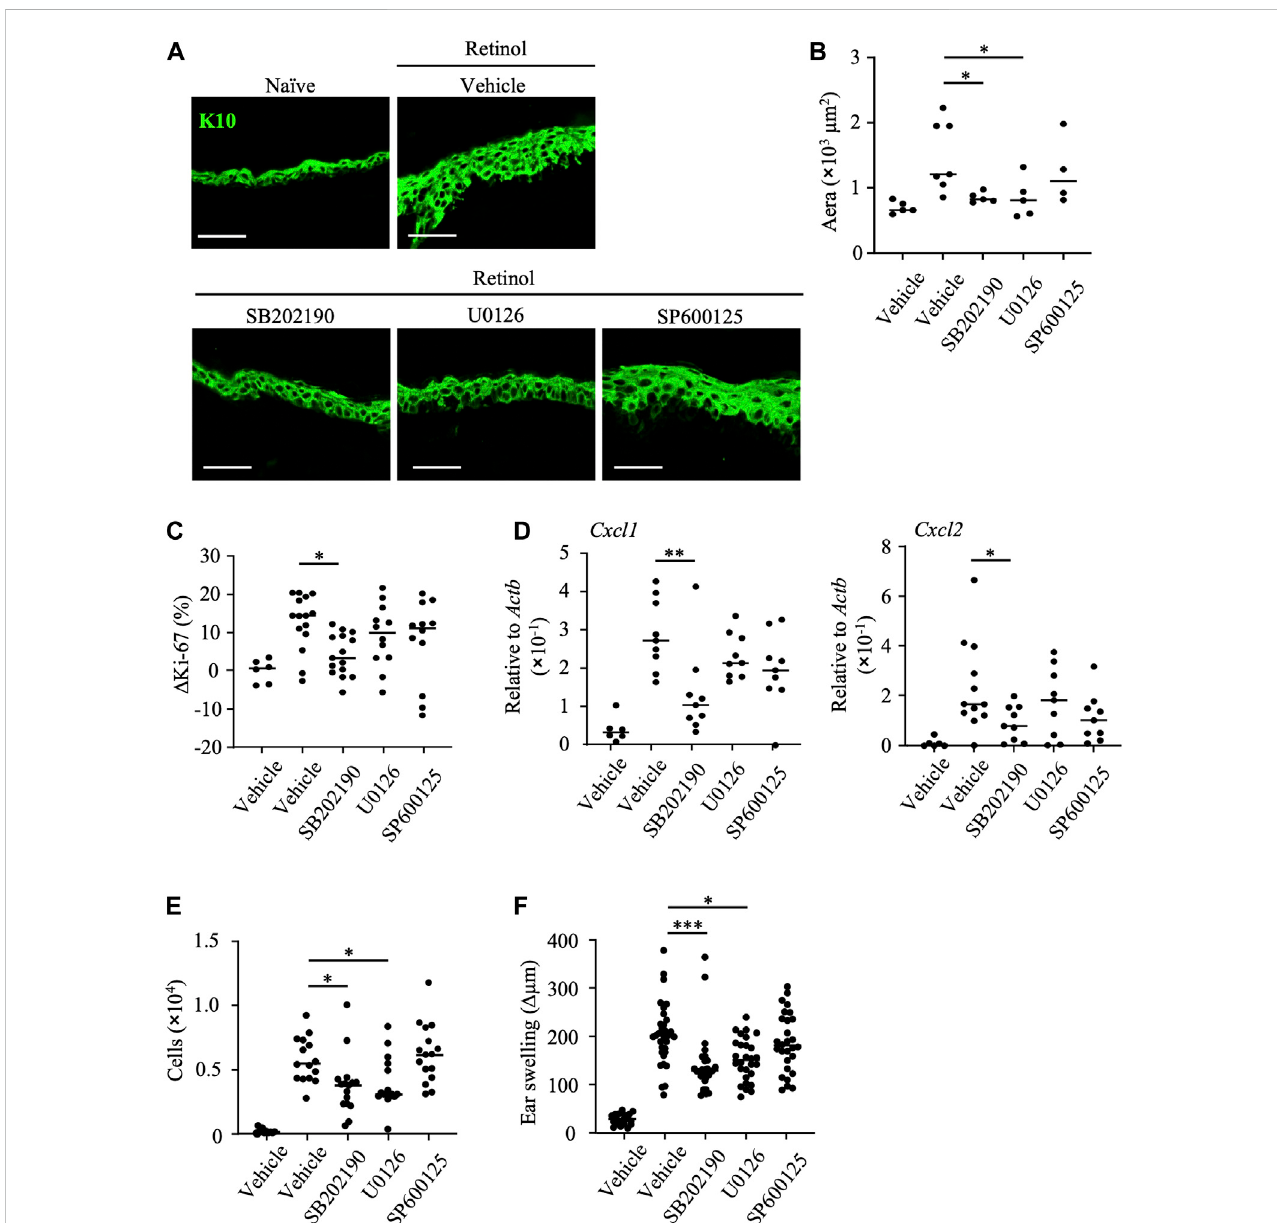
FIGURE 5 Inhibitionofp38MAPKdecreaseskeratinocyteabnormalitiesinducedbyretinol.Aftertopicalapplicationofretinol,thep38MAPKinhibitorSB202190,the MAPK/ERK inhibitor U1026, the JNK inhibitor SP600125, or vehicle was applied topically to both sides of mouse ears. (A) Frozen ear sections obtained on day 4 were stained with anti-K10 antibody. Representative images from three independent experiments are shown. Scale bars, 20 μ m. (B) The area stained for K10 was calculated by using BZ-X700 Analyzer software. (C) The percentage of Ki-67-expressing keratinocytes gated as CD45 − CD31 − CD34 − CD49f + was measured by fl ow cytometry. The rate of increase of Ki-67-positive cells [ Δ Ki-67 (%)] was calculated as (Ki-67 [%] on day 4) — (Ki-67 [%] average in retinol- untreated mice on day 4). Data are combined from four independent experiments. (D) Ear tissues were homogenized to isolate mRNA, and Cxcl1 and Cxcl2 expression was measured by quantitative RT-PCR analysis and normalized to that of Actb . Data are combined from four independent experiments. (E) The number of Ly6G + CD11b + neutrophils was determined on the basis of total cell numbers and fl ow cytometric data. (F) Ear thickness was measured on day 4. Ear swelling ( Δ µm) was calculated as (Ear thickness [µm] on day 4) — (Ear thickness [µm] before the fi rst retinol application). Horizontal bars indicate median values. Data are combined from fi ve independent experiments. * p < 0.05; ** p < 0.01; *** p <